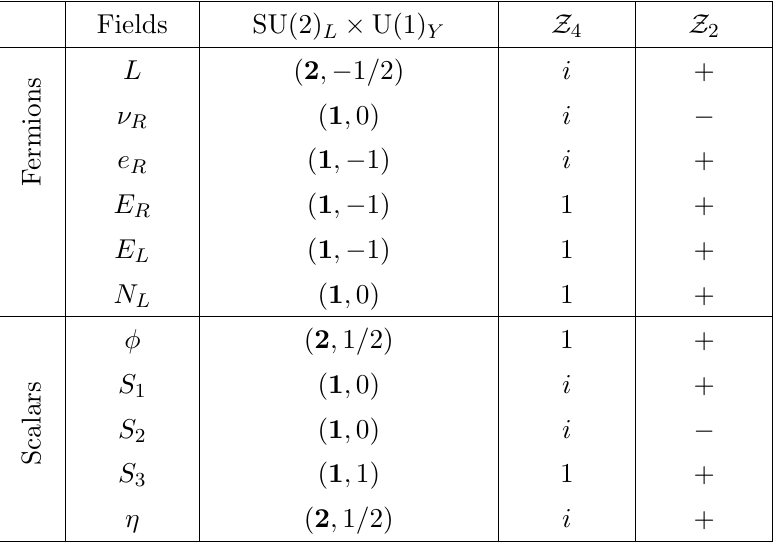
Table 2 . Particle content of the completely genuine example model. The gauge charges along with the charges are also shown. All the (cid:12)elds listed in the table are SU(3) C singlets. The role Z 4 (cid:2) Z 2 of is to protect Diracness and to stabilize the dark matter candidate. The lightest particle out Z 4 of S 1 , S 2 , the neutral component of (cid:17) and the Majorana fermion N L . The the neutrino tree-level mass L(cid:30) c (cid:23) R and it is softly broken to allow the two-loop realization of such